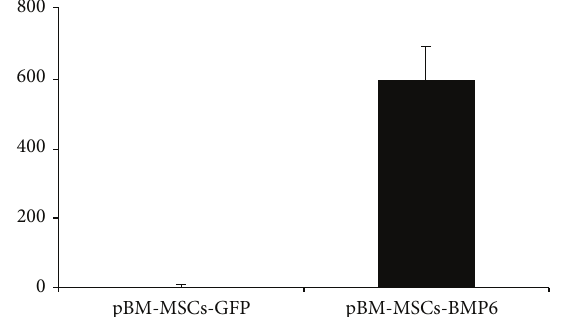
Figure 2: pBM-MSCs nucleofected with rhBMP-6 secrete BMP6 in vitro. Porcine BM-MSCs were nucleofected with cDNA3-pCMV- rhBMP-6 and cultured in vitro. The media were changed after 24 hours and 48 hours after nucleofection the secretion of the BMP6 protein was evaluated using quantitative protein immunoassay (ELISA). The amount of BMP6 secreted was normalized to cell number and compared to the cells that were nucleofected with GFP; bars indicate SE, 𝑛 = 3